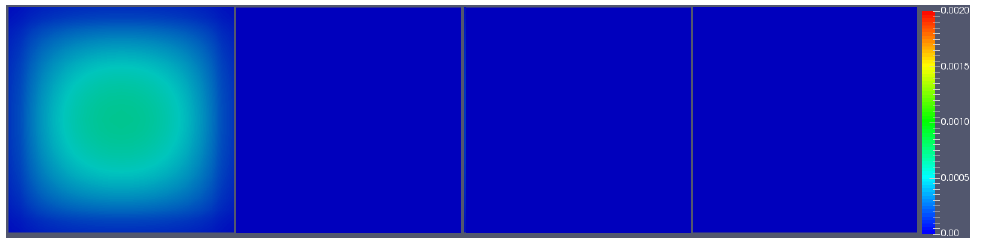
Figure 6. Patterns of carbon dioxide distribution over grain for 8 min, 16 min, 24 min and 32 min.